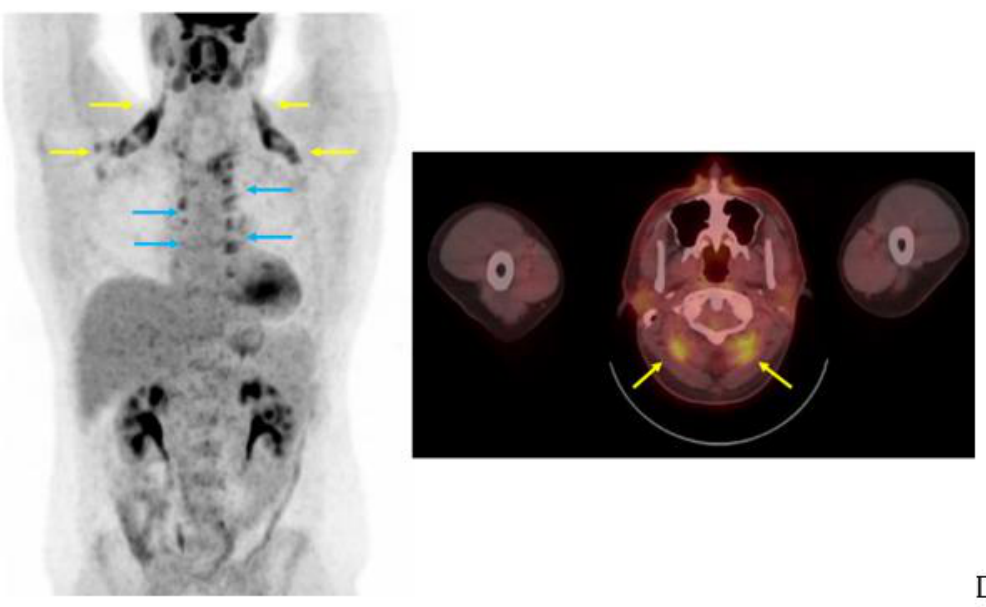
Figure 6. Variation of BAT FDG uptake in clinical patients. Fused coronal FDG-PET / CT, coronal CT, and fused axial FDG-PET / CT ( A – C ). ( A ) BAT FDG uptake in a woman with normal BMI. Note supraclavicular (yellow arrows), skull base (red arrow), paraesophageal (blue arrow), and perinephric (white arrow) uptake. ( B ) Supraclavicular BAT in an obese woman (yellow arrows). ( C ) Diffuse FDG uptake in subcutaneous WAT in a male patient (yellow arrows). ( D ) A male patient with extensive supraclavicular FDG uptake extending into the upper neck (yellow arrows) and paravertebral BAT activity (blue arrows).